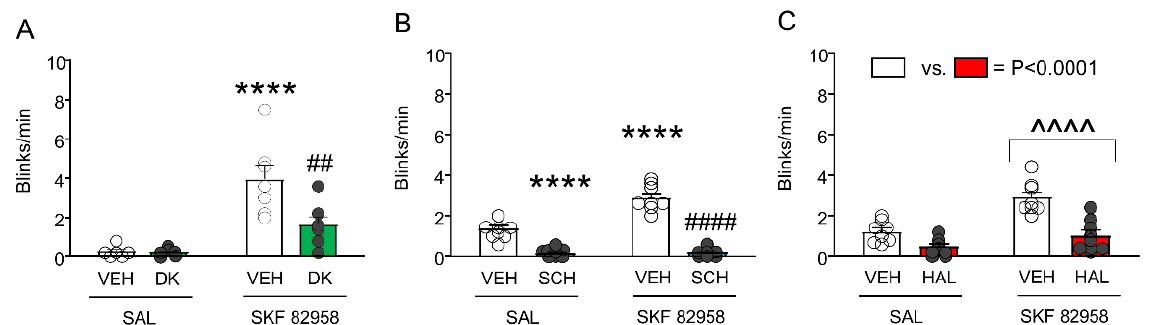
Figure 7. Effects of DK-I-56-1 (DK, 10 mg/kg, IP) and dopaminergic antagonists on the exacerba- tion of spontaneous eye blinking in C57BL/6 mice treated with SKF 82,958 (0.5 mg/kg, IP). ( A ) Two-way ANOVA showed that SKF 82,958 significantly increased eye blinking (Main effect: F(1,22) = 31.45, p = 0.00001), while DK reduced it (Main effect: F(1,22) = 6.75, p = 0.02). A significant interaction between the two treatments was found (F(1,22) = 6.37, p = 0.02), revealing that DK sig- nificantly reduced the blinks in mice treated with SKF 82,958. ( B ) The D 1 antagonist SCH 23,390 (0.5 mg/kg, IP) also countered the elevation in eyeblinks caused by SKF 82,958 (Main effect of SKF 82,958: F(1,30) = 28.68, p < 0.00001; Main effect of SCH 23,390: F(1,30) = 181.6, p < 0.00001; Interac- tion: F(1,30) = 25.10, p = 0.00002). ( C ) The D 2 antagonist haloperidol (HAL, 0.5 mg/kg, IP) reduced eyeblinks, but this effect did not interact with the elevation of eyeblinks induced by SKF 82,958. (Main effect of SKF 82,958: F(1,28) = 22.98, p = 0.00005; Main effect of HAL: F(1,28) = 25.59, p = 0.00002; Interaction: F(1,28) = 2.79, NS). ^^^^ p < 0.0001 main effect of SKF 82,958 vs. saline (SAL); **** p < 0.0001 vs. mice treated with VEH and SAL; ## p = 0.001 and #### p < 0.0001 vs. mice treated with VEH. n = 6–8/group. For further details, see text.